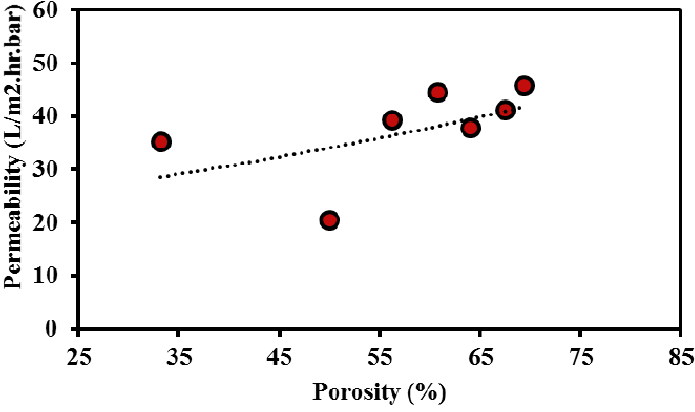
Figure 8 . Variation of permeability with porosity level for different porous membranes. Figure 8. Variation of permeability with porosity level for di ff erent porous